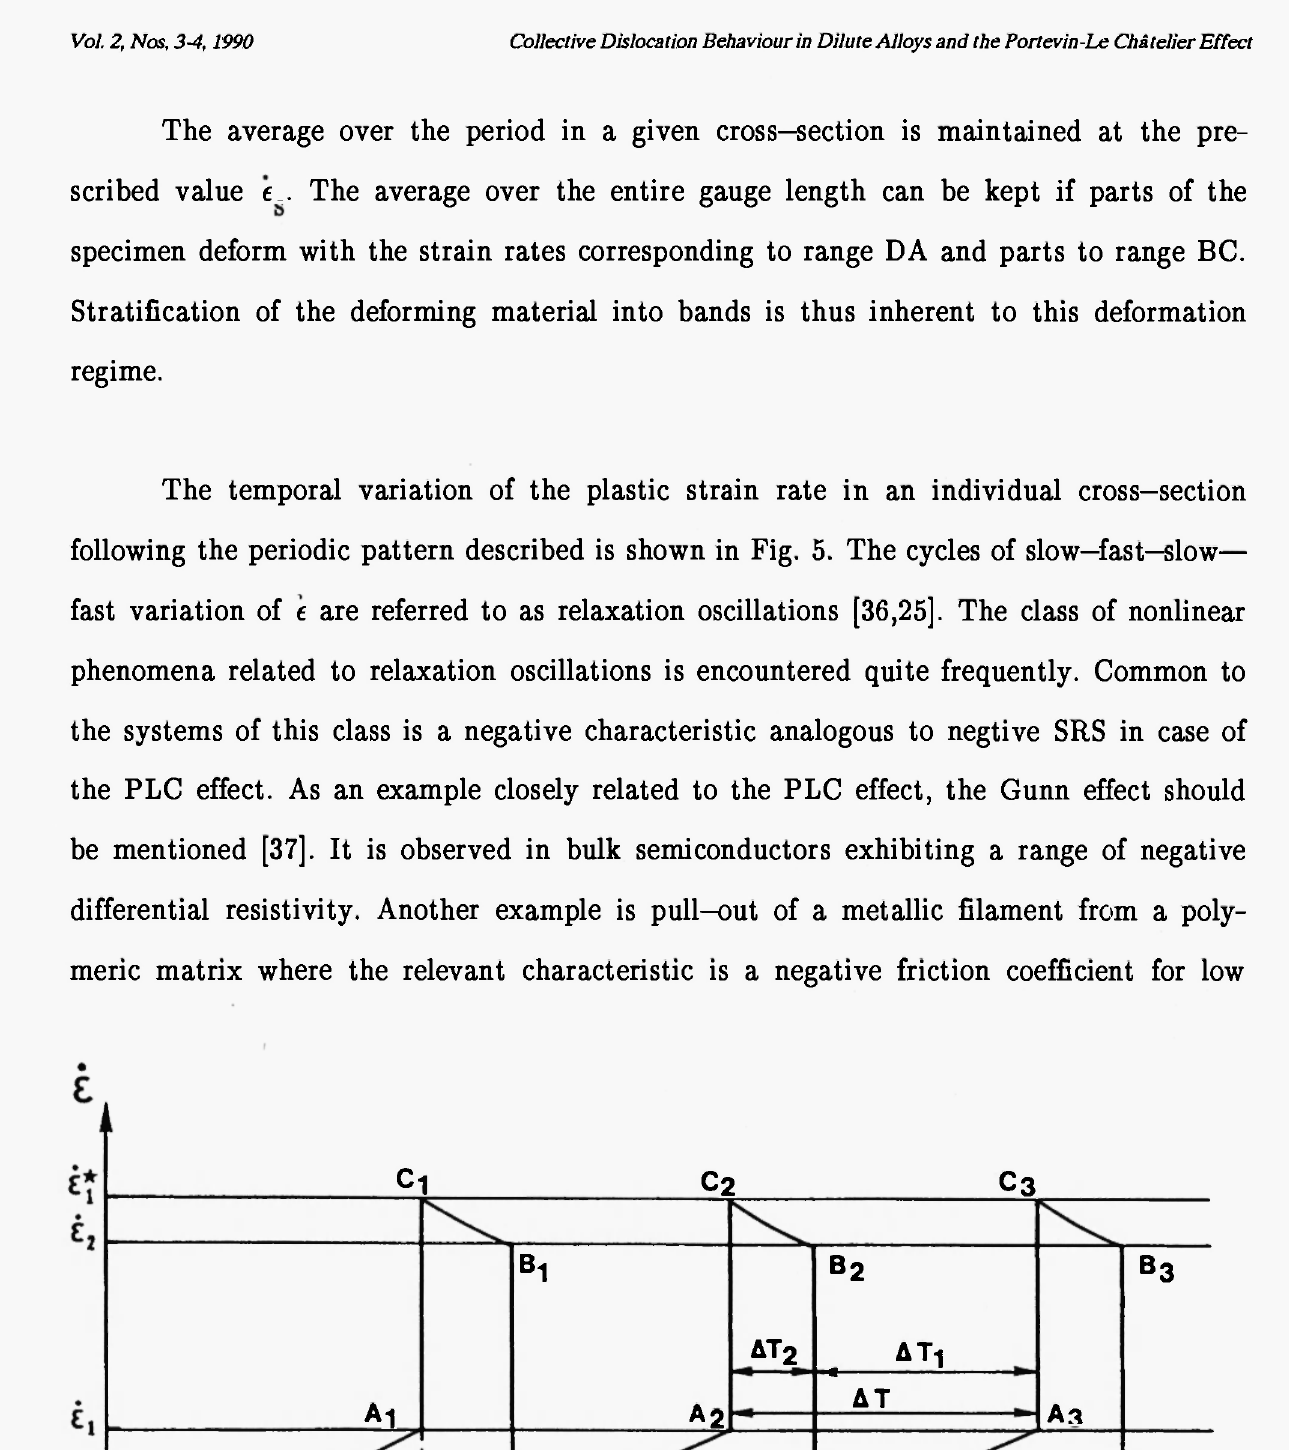
Fig. 5. Strain rate profile as a function of time at a given location within a specimen. Strain rate jumps A—>C and B—>D (Fig. 4) are found again in this diagram as the jumps Ai—»Ci and Bi—>Dj,